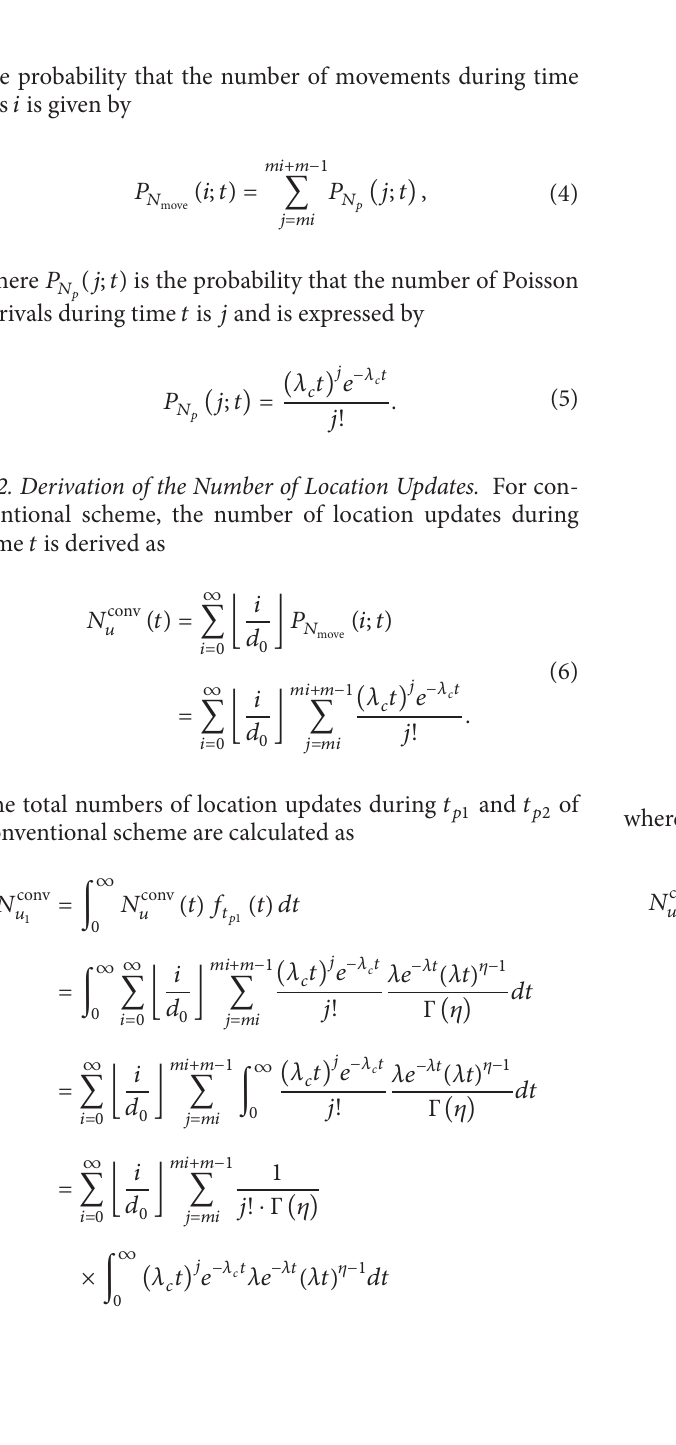
Figure 2: Timing diagram for the proposed movement-based scheme and data traffic